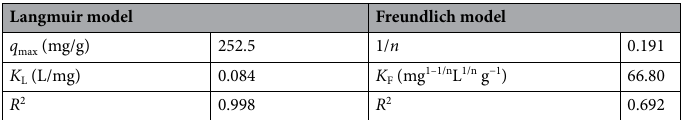
Table 1. The parameters of Sr sorption by Z4A calculated using Langmuir and Freundlich isotherm models.